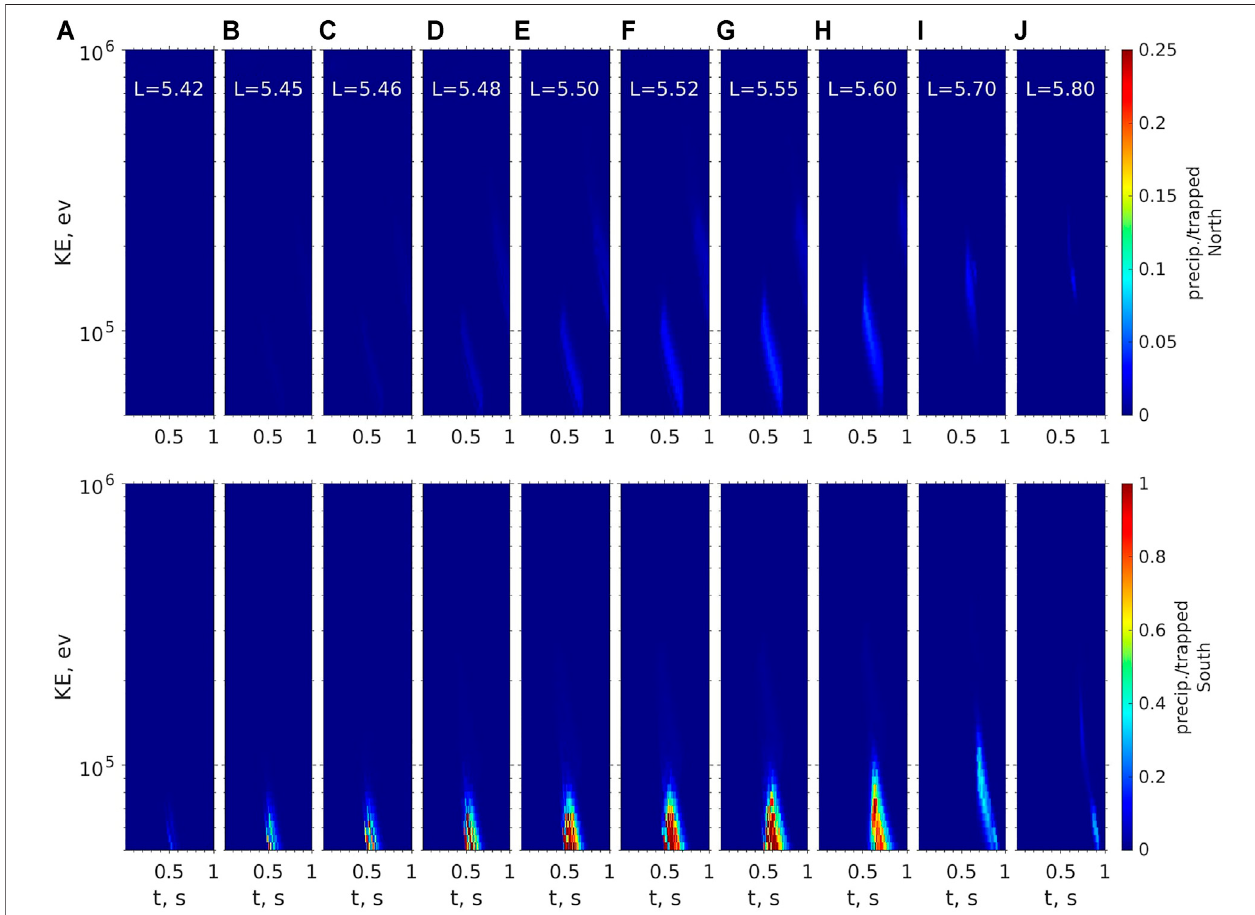
FIGURE 7 | Modeled ratio of precipitating to trapped electron fl uxes at virtual northern (top panels) and southern (bottom panels) LEO satellites due to the presence of the nonducted wave shown in Figure 5 at selected fi eld lines with L values from 5.42 to 5.80 (A – J) .